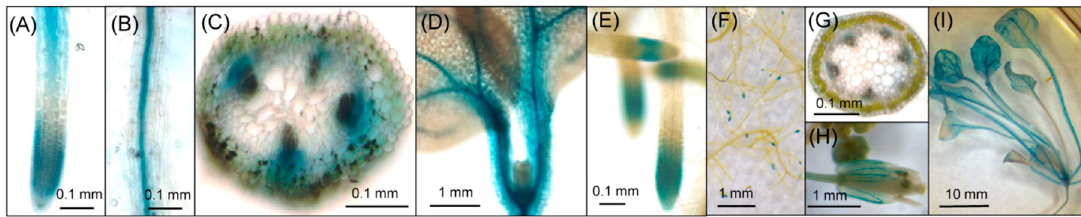
Figure 1. Histochemical analysis of β -glucuronidase (GUS) activity in typical T 2 transgenic plants expressing the AtHKT1;1pro – GUS construct. Seven-day-old seedlings or plants at the reproductive stage (four weeks old) were used for GUS staining. ( A – D ) Plants at seedling stage; ( E – I ) plants at reproductive stage; ( A , E ) root tips; ( B ) middle part of the root; ( C ) hypocotyl cross-section; ( D ) cotyledon; ( F ) roots; ( G ) cross-section of the stem; ( H ) petals; ( I ) leaves. More than three different plants per line were analyzed, and photos of a representative plant are shown.